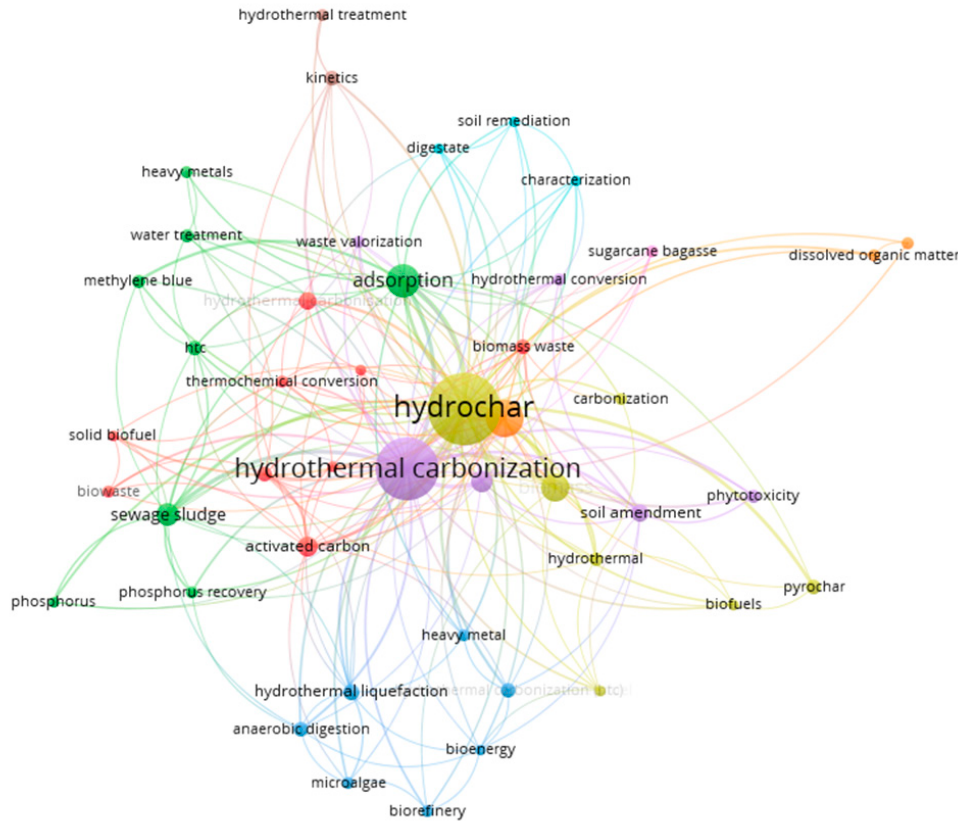
Figure 3. Heat map of keywords for articles about the use of hydrochar.